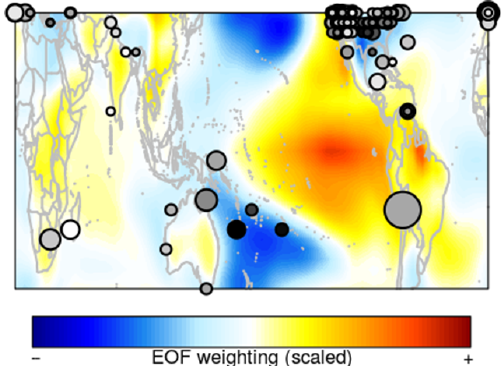
Figure 6. Temperature EOF with proxy locations. As Fig. 5, but for